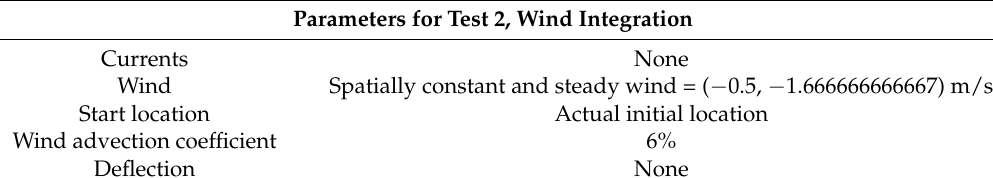
Table 4. Parameters for test 2, wind integration.